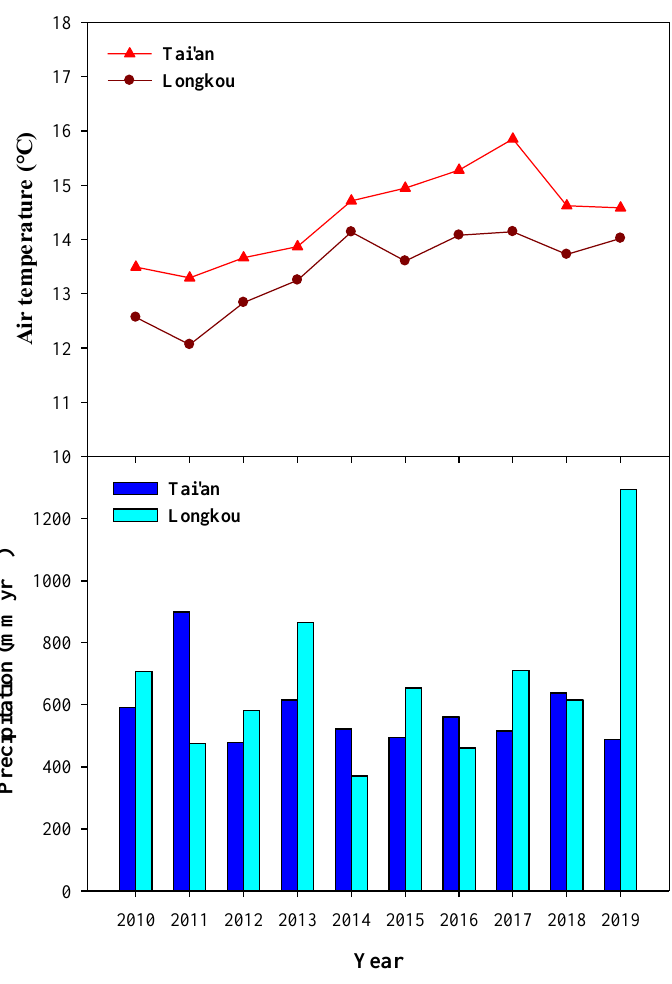
Figure 2. Temperature and precipitation of the Tai’an and Longkou experimental sites.